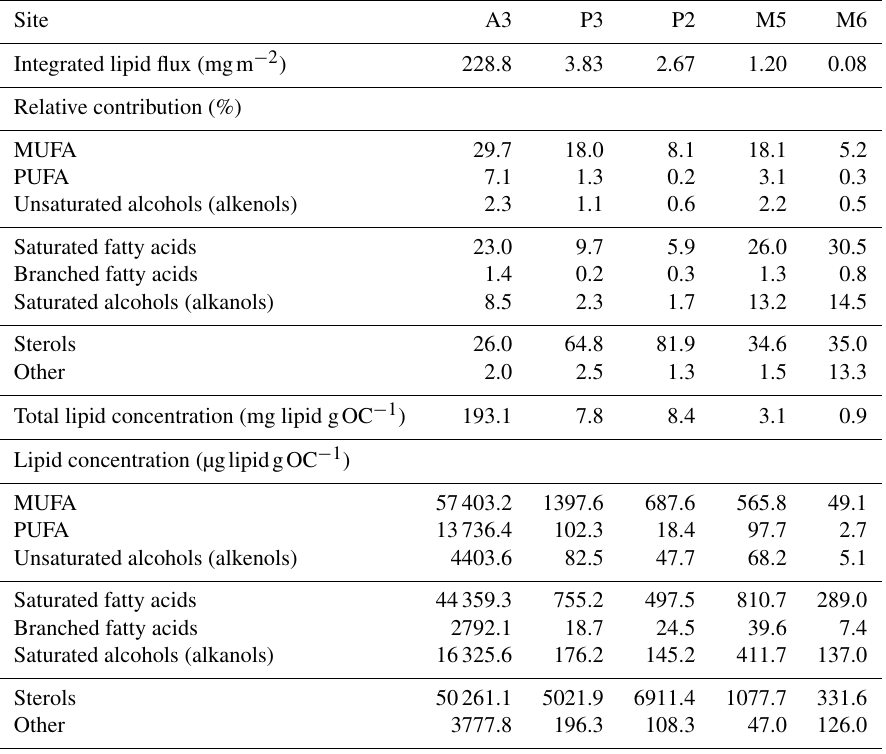
Table 2. Total annual lipid flux, relative contribution of lipid classes and lipid concentrations for the five sediment trap deployments. Labile – MUFA (monounsaturated fatty acids), PUFA (polyunsaturated fatty acids) and unsaturated alcohols; semi-labile – saturated fatty acids, branched fatty acids and saturated alcohols; refractory – sterols, other (Wolff et al., 2011). Sediment trap deployment periods are presented in Table 1. Individual compound fluxes, concentrations and relative contributions are included in Tables S1–S5 in the Supplement. A full list of the compounds categorized as others can also be found in the Supplement